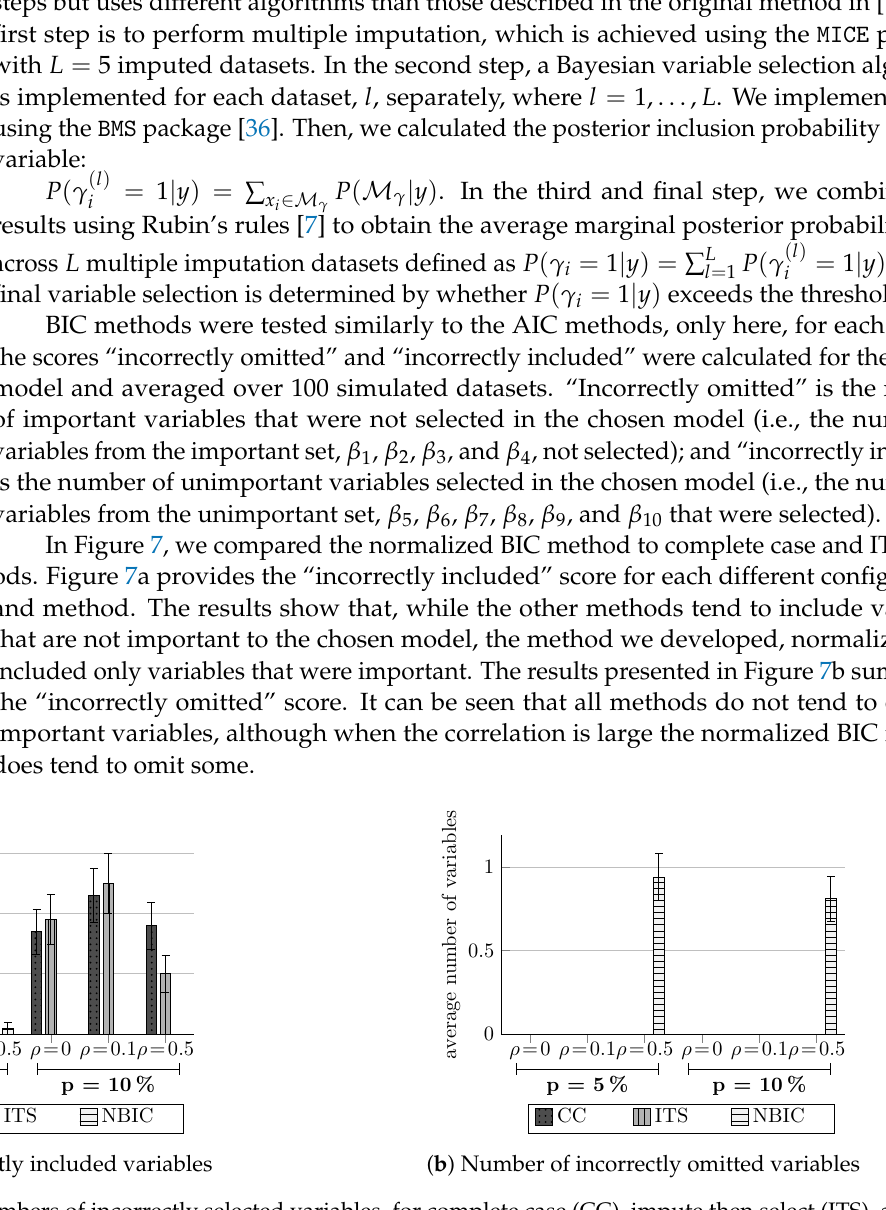
Figure 7. Comparing the numbers of incorrectly selected variables, for complete case (CC), impute then select (ITS), and normalized BIC (NBIC) methods, averaged over 100